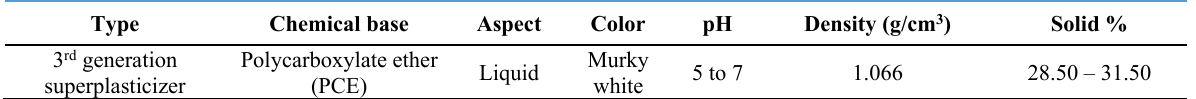
Table 1. Polycarboxylates-vased plasticizer additive